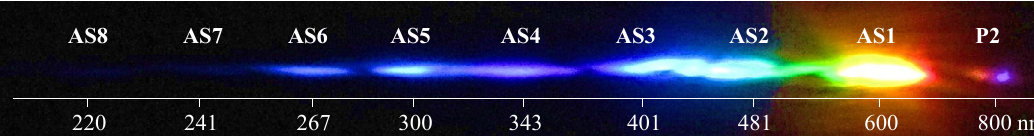
Figure 4. Photograph of the multicolor